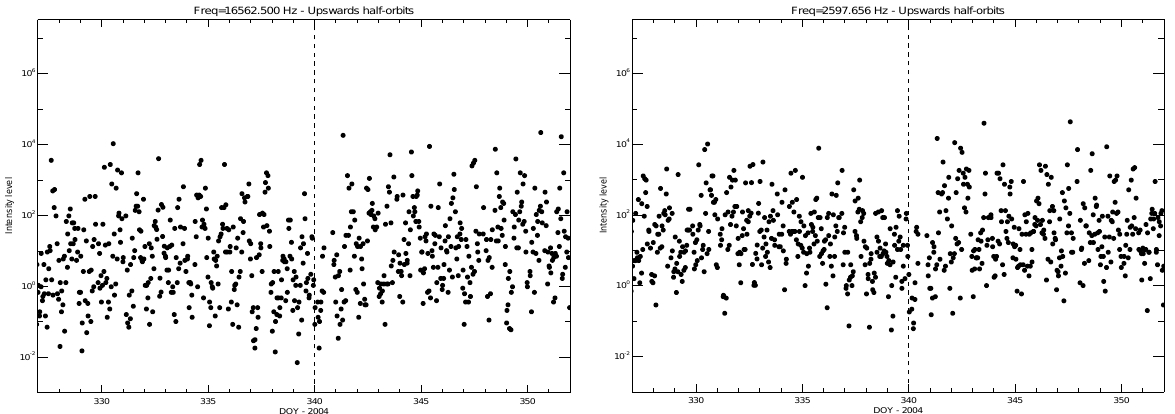
Fig. 3. Variation of the intensity level (expressed in mV 2 m − 2 Hz − 1 ) versus the day of the year 2004 (from 22 November to 17 December 2004). The left and right figures correspond to the intensity variation at 16 652.5Hz (the closest frequency to the German transmitter signal 16 560Hz) and 2 597.656Hz, respectively. The EQ date corresponds to 5 December 2004, and is indicated by a dashed vertical